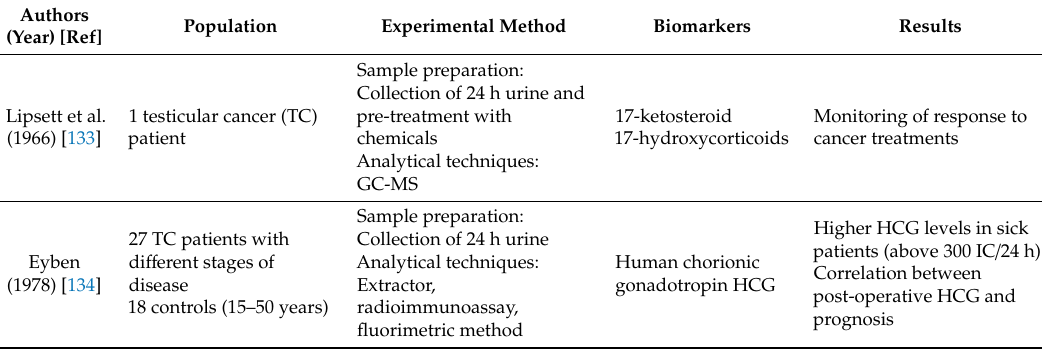
Table 10. Literary studies investigating urinary testicular cancer